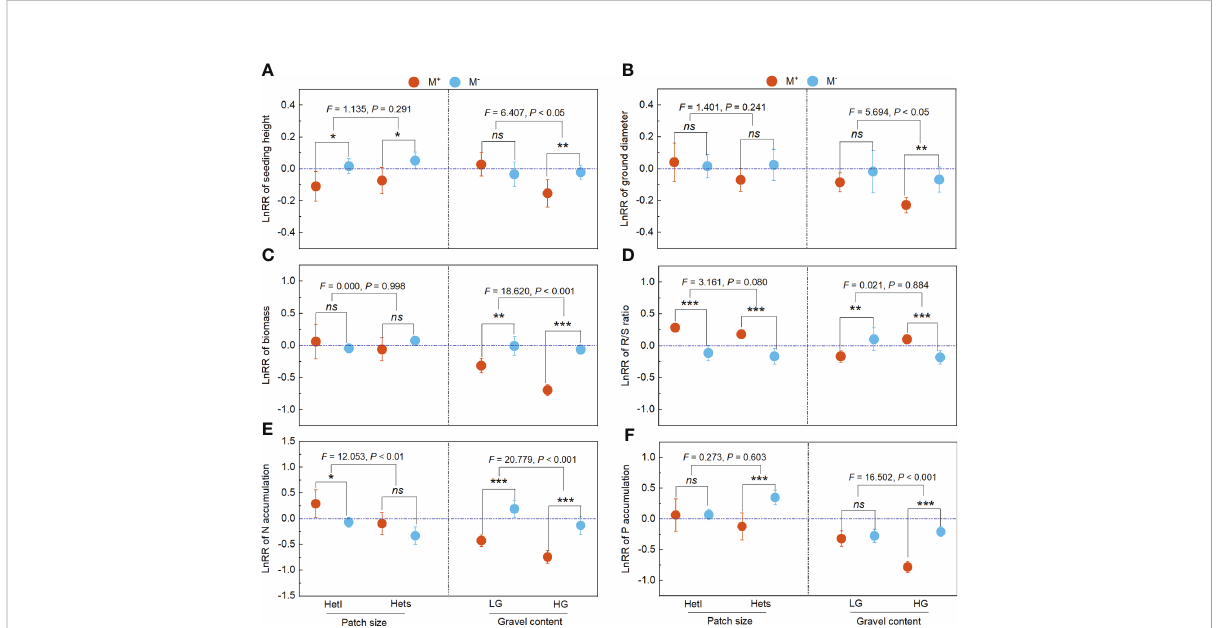
FIGURE 4 The LnRR of plant growth and nutrition across patch size and gravel content. M + and M – ; Hetl and Hets; LG and HG, implications are the same as in Figure 2. the * indicate signi fi cant differences between M + and M – (* indicate P < 0.05; ** indicate P < 0.01; *** indicate P < 0.001), the ns indicates non-signi fi cant differences between M + and M – . Additionally, the F and P values were obtained from the two-way ANOVA, indicating the effect of patch size and gravel content on the LnRR for the seedling height (A) , ground diameter (B) , biomass (C) , R/S ratio (D) , N accumulation (E) , and P accumulation (F) of B . pilosa